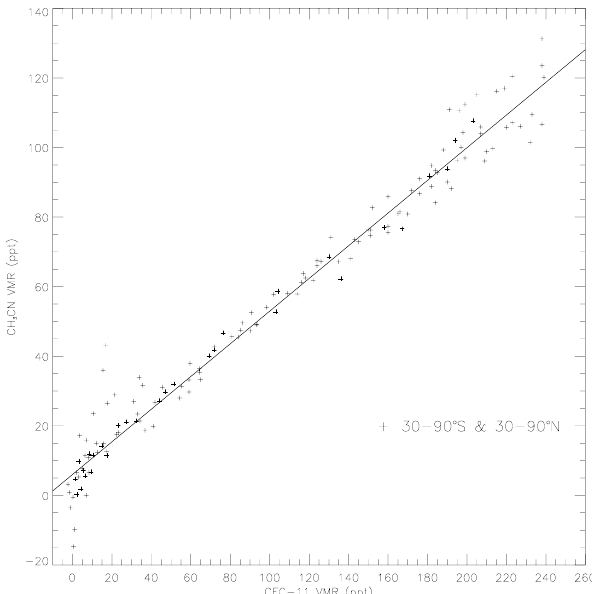
Fig. 5. Linear correlation between CH 3 CN and CFC-11 ACE-FTS data (in 10 ◦ latitude bins) in the extratropical regions (30–90 ◦ S